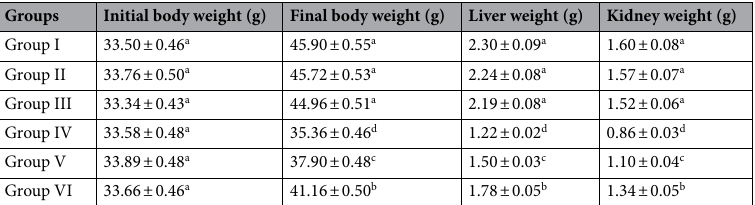
Table 2. Effects of AFB 2 and resveratrol application on body and organ weights. Values are shown as mean ± SEM (n = 6). Group I: control, Group II: 10 mg/kg b.w resveratrol, Group III: 20 mg/kg b.w resveratrol, Group IV: 20 µg/kg b.w AFB 2 , Group V: 10 mg/kg b.w resveratrol + 20 µg/kg b.w AFB 2 , Group VI: 20 mg/kg b.w resveratrol + 20 µg/kg b.w AFB 2 . Data shown with different letters (a–d) in the same column are statistically significant (p <